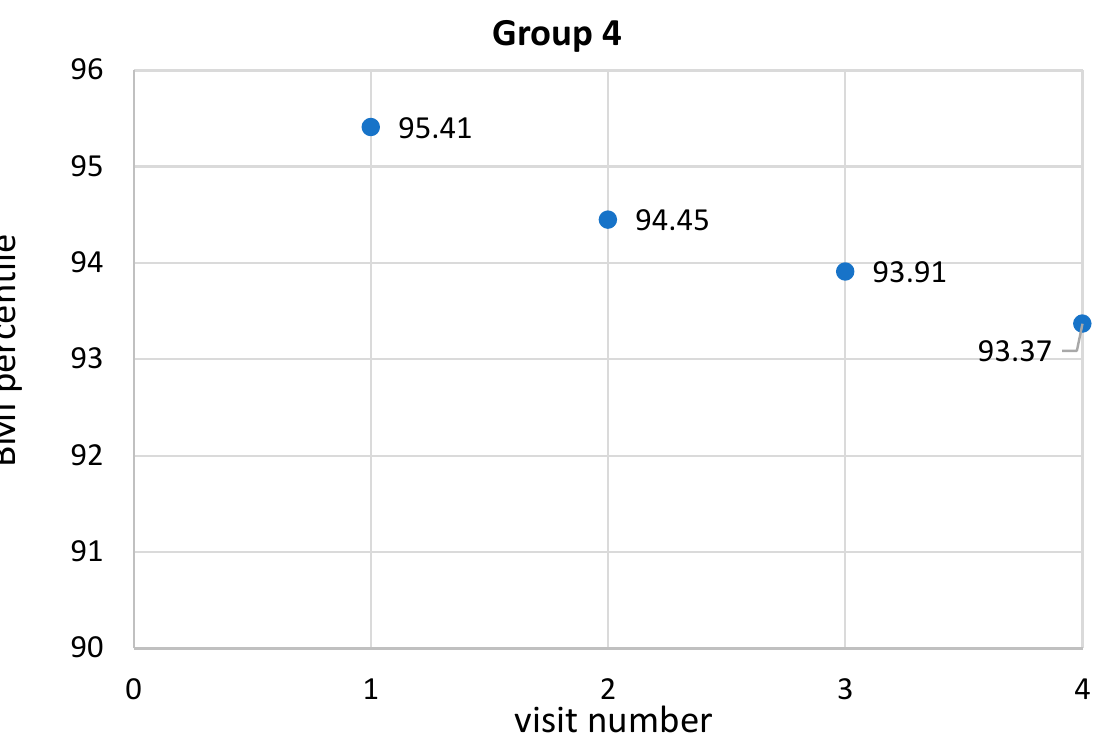
Figure 4. Change in BMI percentile during subsequent intervention visits.